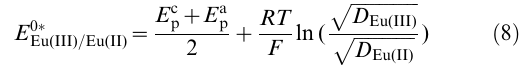
Dy(III); . , Nd(III) measured in BmimBr at GC electrode.